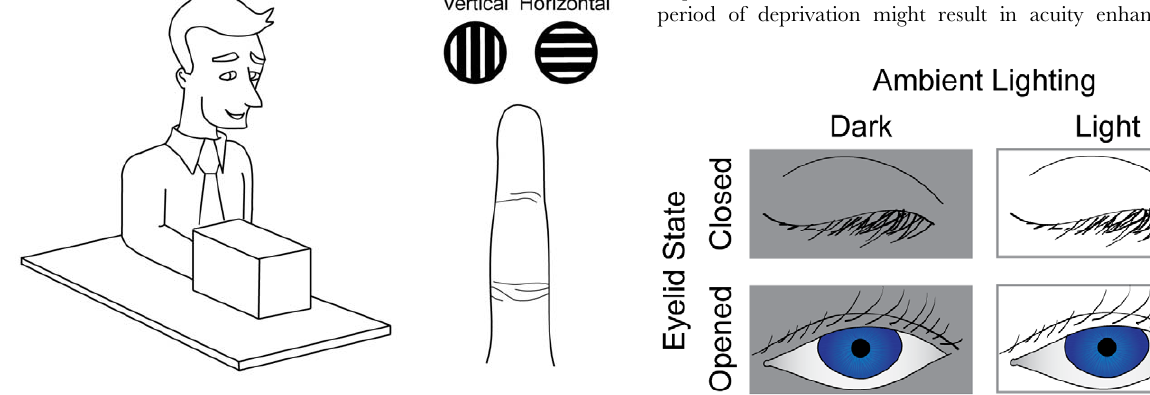
Figure 2. Experiment 1 conditions . In a two-by-two repeated measures design, every participant was tested under four conditions: two conditions of ambient lighting (dark and light) by two conditions of eyelid state (eyes opened and eyes closed). Each participant completed the four conditions twice. The experiment duration was approximately 80